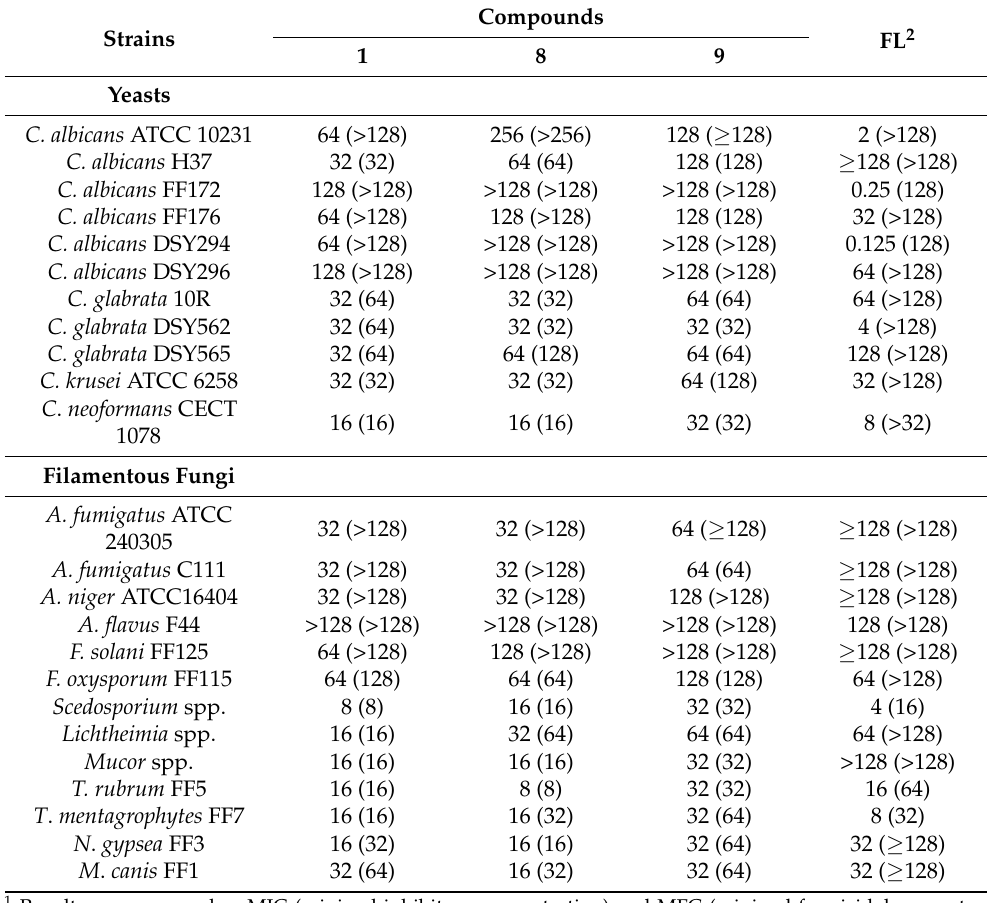
Table 1. Antifungal activity—MIC (MFC) 1 , µ g/mL—of compounds 1 , 8 , and 9 , and fluconazole against yeast and filamentous fungi